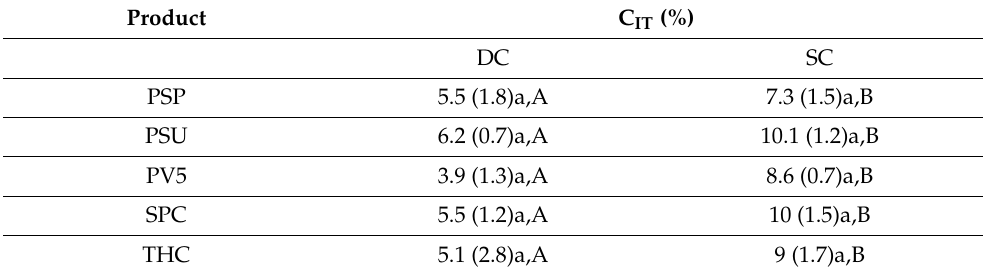
* Means and standard deviations (in parentheses). Same low-case letters show mean values with insignificant differences between the products within the same curing mode, whereas same upper-case letters show mean values with insignificant differences for the same product between the two curing modes ( p > 0.05).